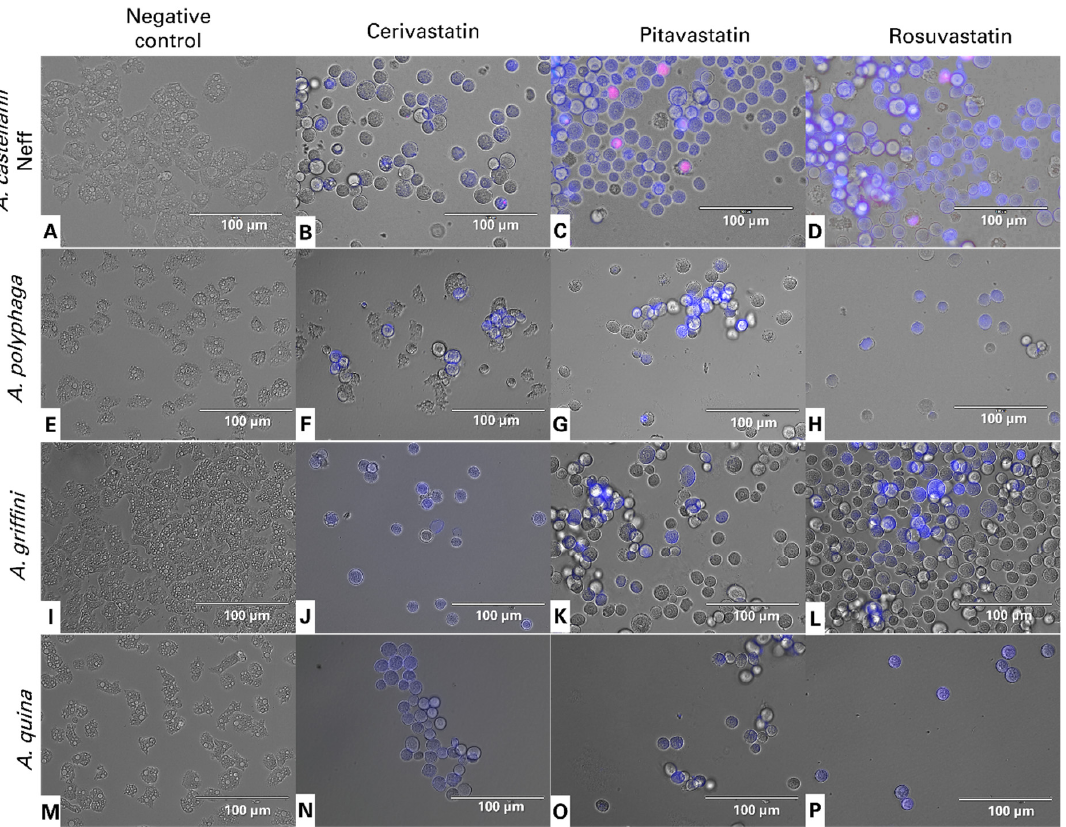
Figure 2. Images of Acanthamoeba castellanii Neff ( A – D ), A. polyphaga ( E – H ), A. griffini ( I – L ) and A. quina ( M – P ) showing the effect of IC 90 of cerivastatin ( B , F , J , N ), pitavastatin ( C , G , K , O ) and rosuvastatin ( D , H , L , P ), relative to the negative control (non-treated amoebae) ( A , E , I , M ), after 24 h of incubation in vitro. Hoechst stains treated trophozoites nuclei in bright blue, showing chromatin condensation, while red fluorescence corresponds to the propidium iodide dye, which stains the DNA of dead cells. All images were captured using an EVOS FL Cell Imaging System EVOS™ M5000 (40× magnification). Images shown are representative of the cell populations observed in each experimental condition.